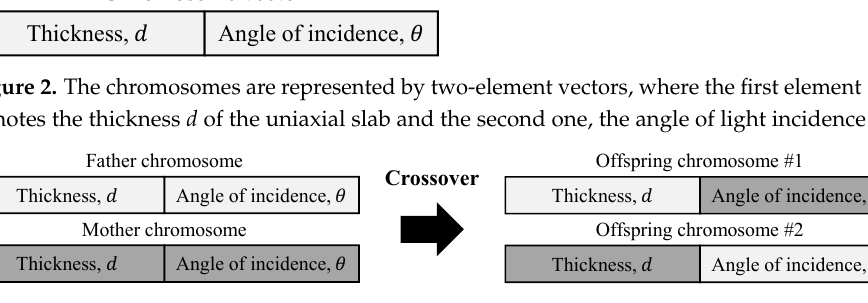
Figure 3. As the figure shows, the crossover operation, also known as recombination, is used to combine the genetic information of two chromosomes, called parents, into two new offspring. The recombination is realized randomly choosing two chromosomes out of the set with the fittest chromosomes, N fitness . Different colors are used to illustrate the recombination procedure.